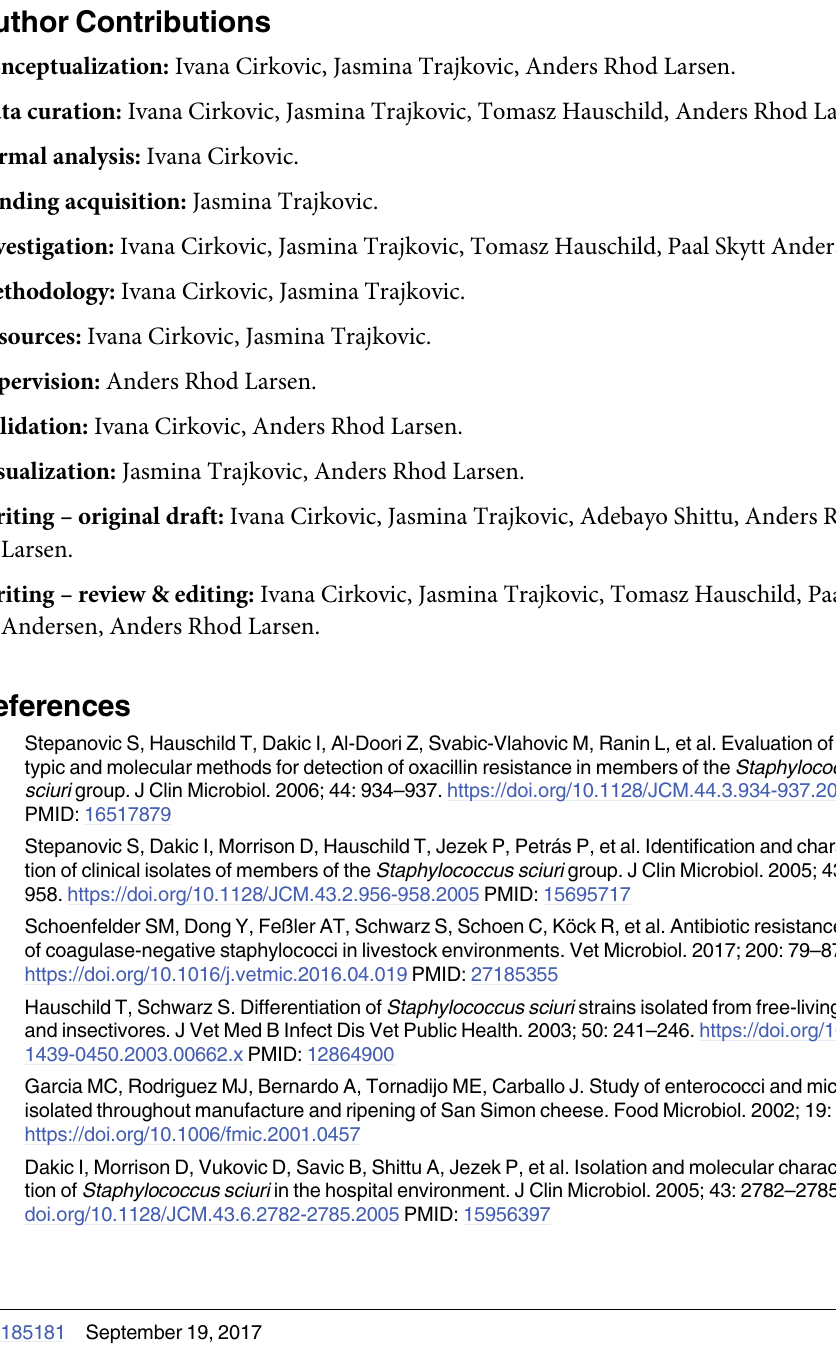
S1 Table. Raw data. Distribution of MRSS carriers and non-carriers stratified by population characteristics and characteristics of MRSS strains isolated from